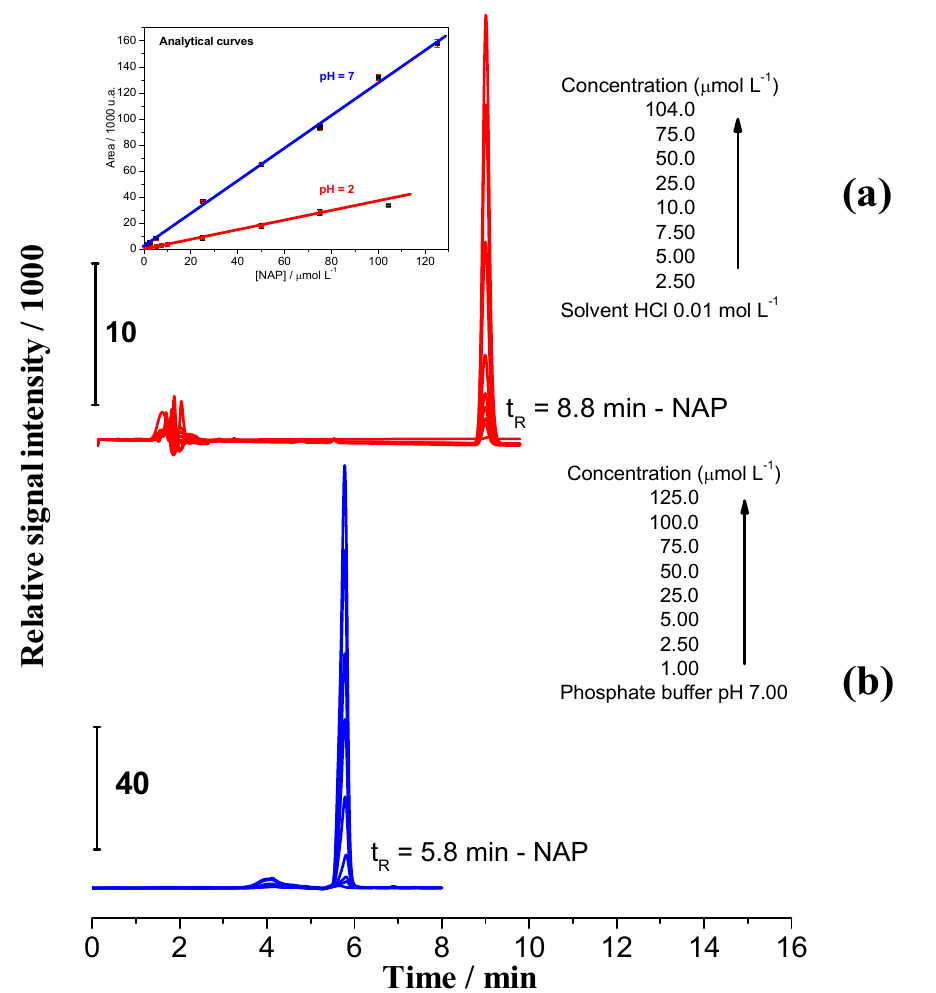
Figure 4. Chromatograms of NAP in different concentrations ( a ) at pH 2.00, details inserted of the signal referent to NAP in HCl 0.01 mol L −1 solution; ( b ) at pH 7.00, details inserted of the signal referent to the phosphate buffer pH 7.00.